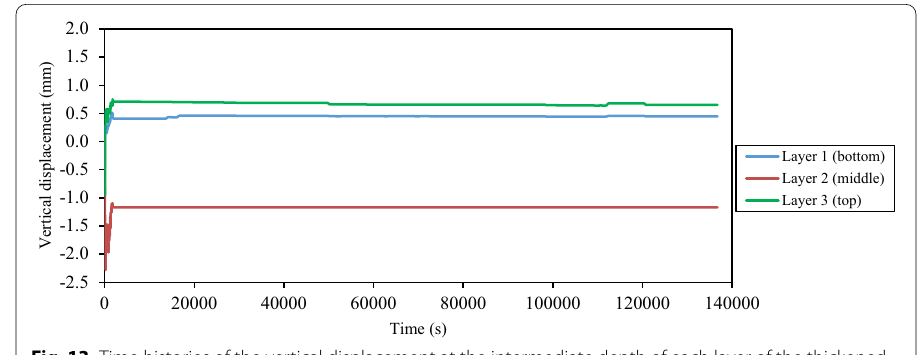
Fig. 13 Time histories of the vertical displacement at the intermediate depth of each layer of the thickened tailings deposit during and after shaking